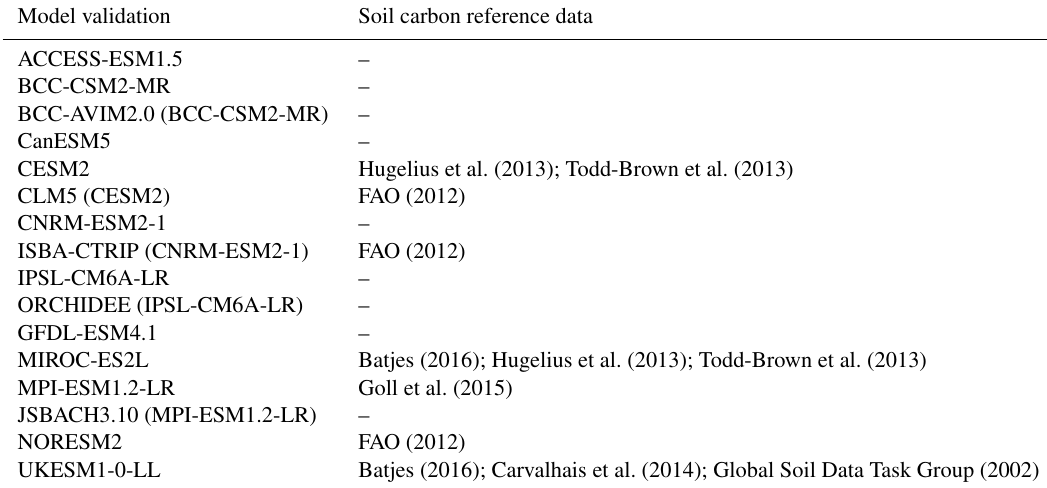
Table 4. The source for soil carbon data referenced by each modelling group for ESM or LSM simulations. Adjacent contributions from the same modelling group are banded in a common fashion for readability. LSM-focused validations by each modelling group are presented with the associated ESM in